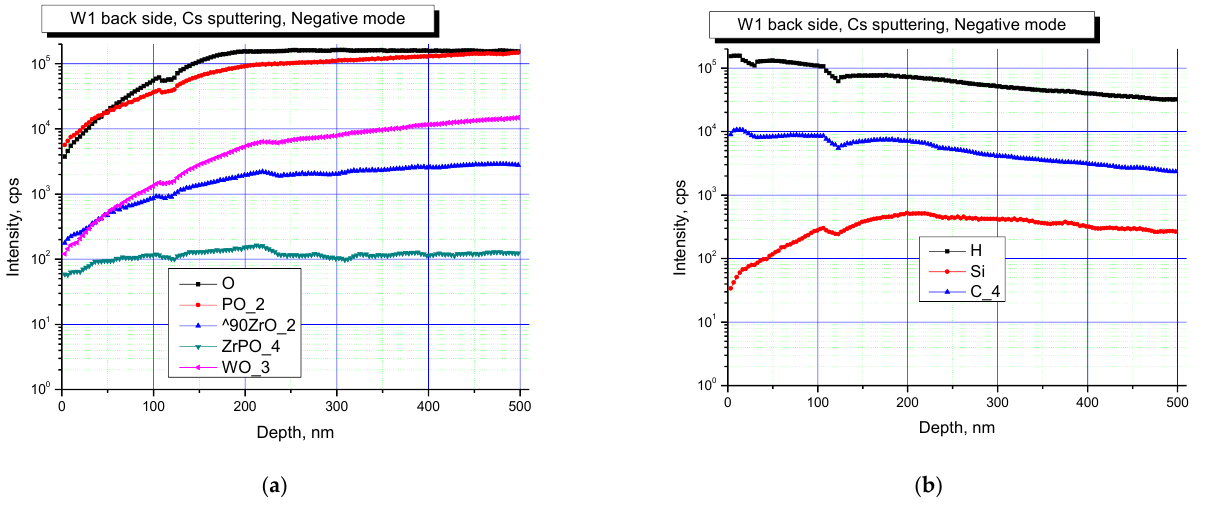
Figure 5. Profiles of main ( a ) and doping ( b ) elements on the surface of the Na 0.5 Zr 2 (PO 4 ) 2.5 (WO 4 ) 0.5 ceramics in negative secondary ion detection mode.